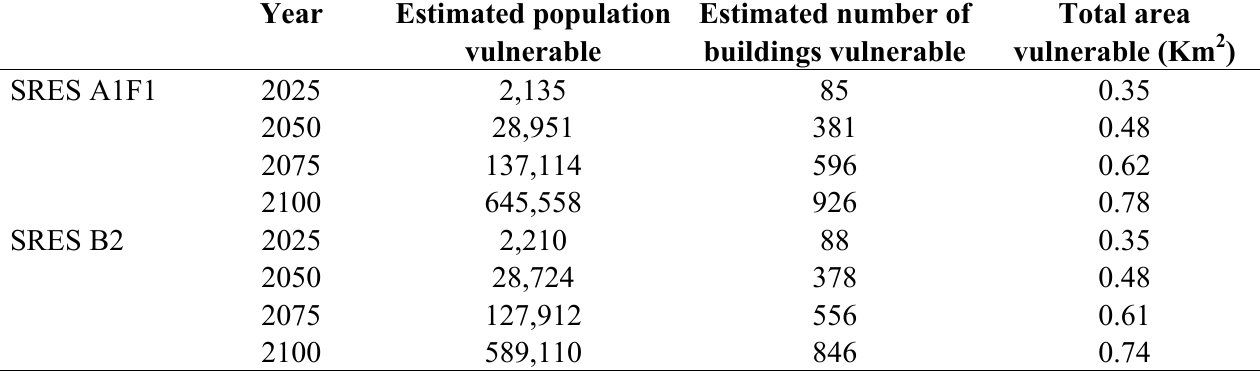
Table 5. Estimated Population, area and buildings to be lost in the projected